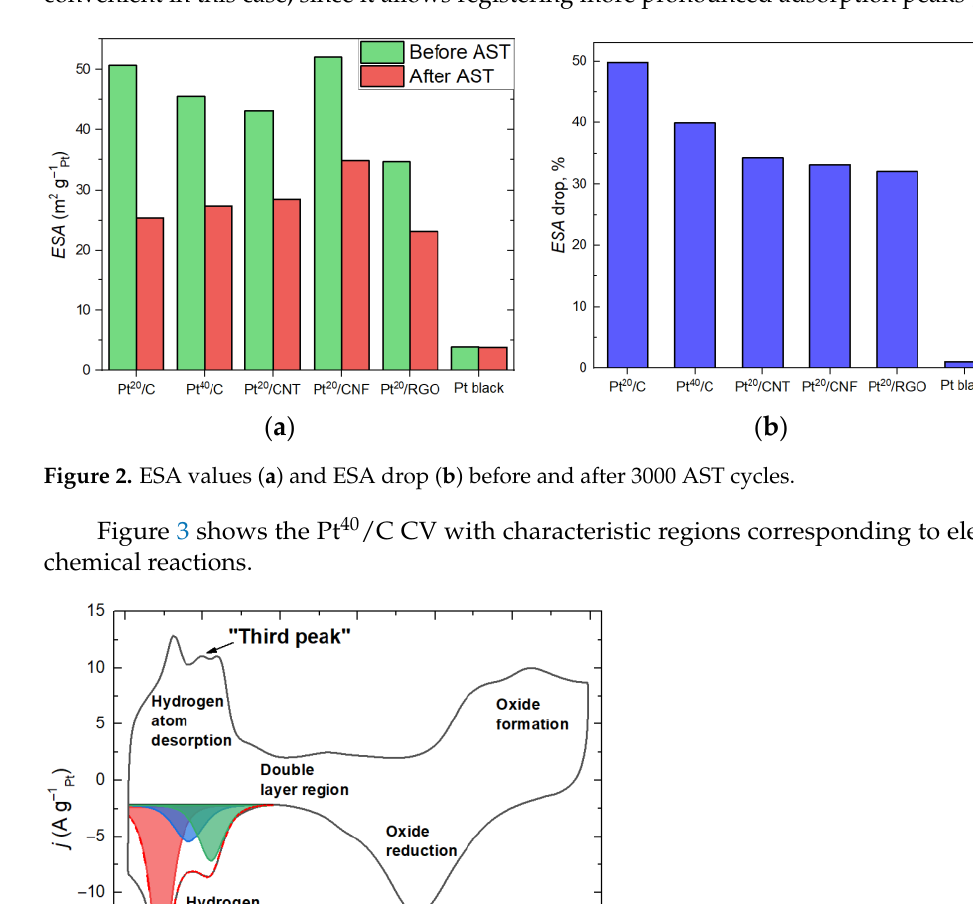
Figure 2. ESA values ( a ) and ESA drop ( b ) before and after 3000 AST cycles.